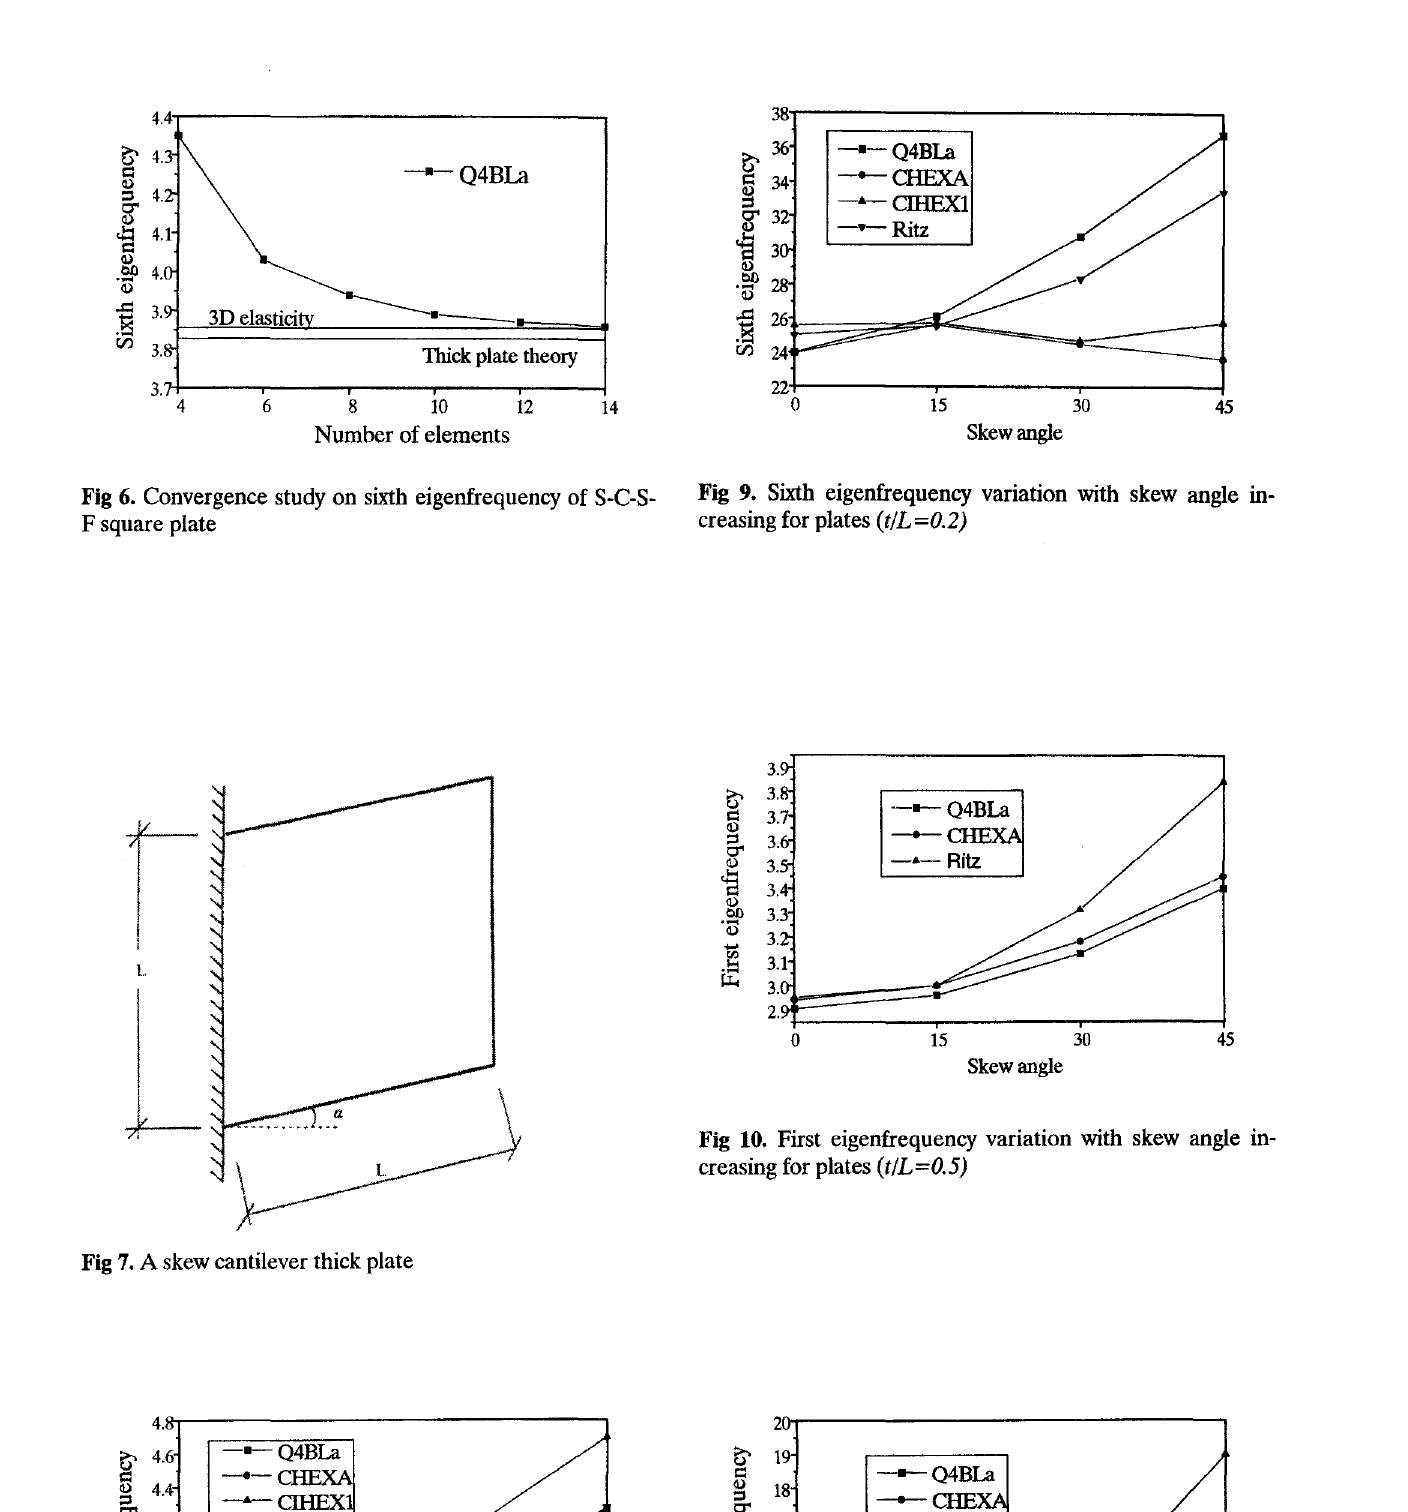
Fig 8. First eigenfrequency variation with skew angle in creasing for plates (t!L=0.2)